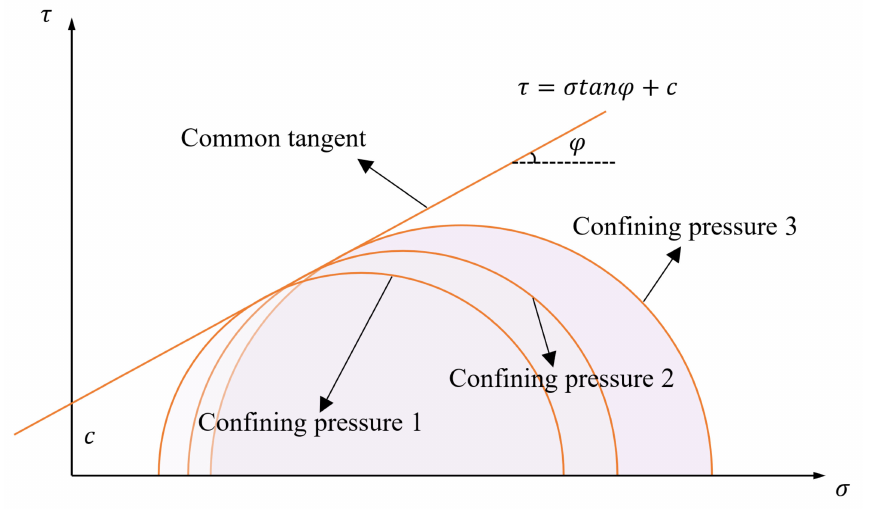
Figure 10. Effect of LS content on unconfined compression strength of cement-soil after freeze– thaw